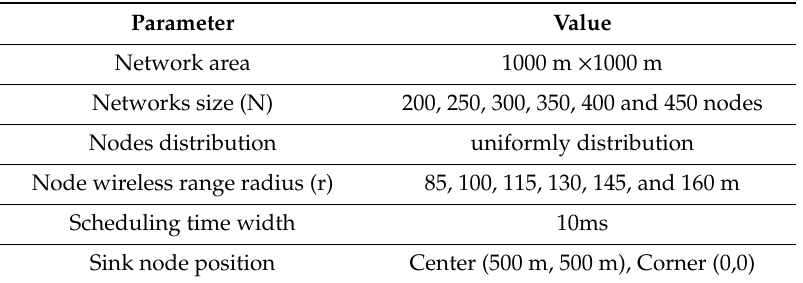
Table 3. Simulation